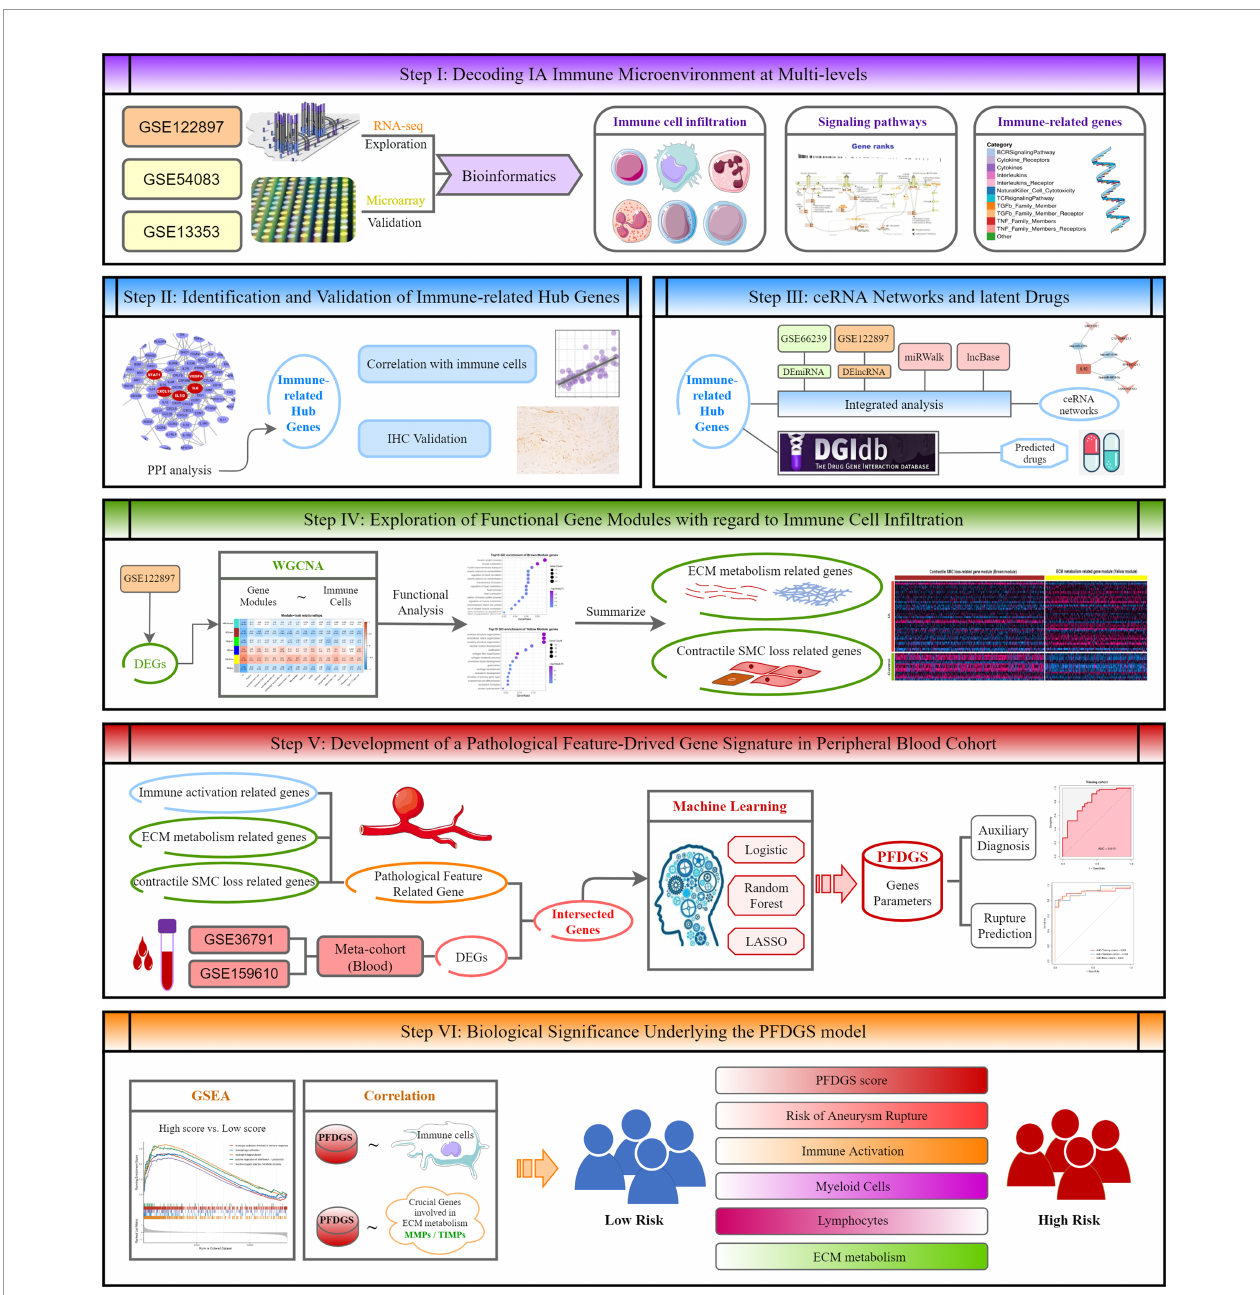
FIGURE 1 | The overall work fl ow of this